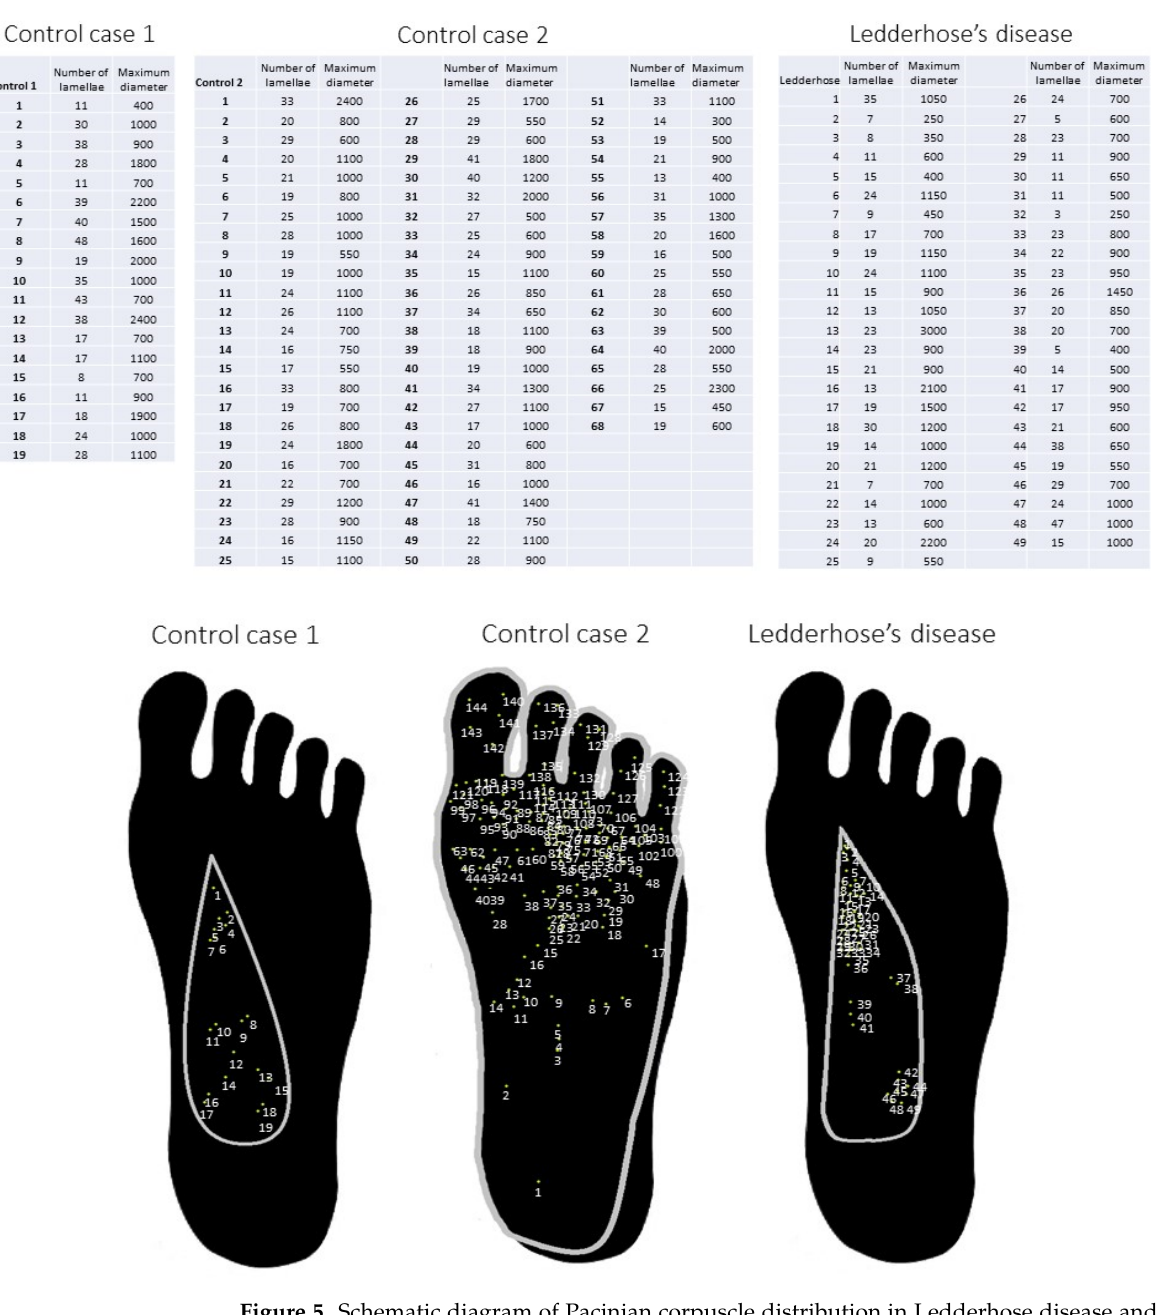
Figure 5. Schematic diagram of Pacinian corpuscle distribution in Ledderhose disease and in